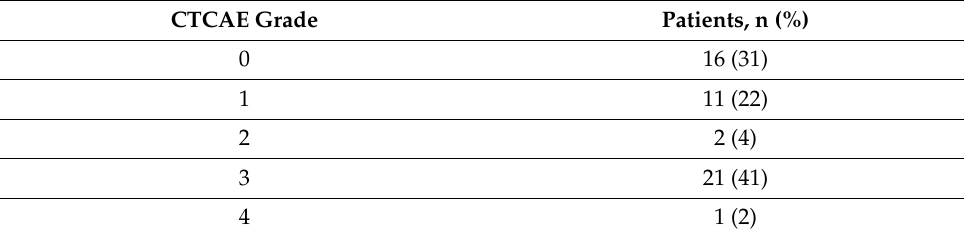
Table 4. CTCAE grade classification at the first follow-up after treatment (n =